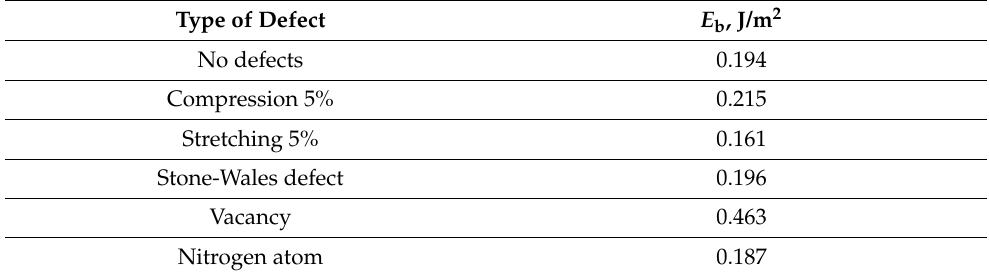
Table 1. Interaction energy of AlN surface with pristine, strained and defected graphene calculated with the density functional theory.